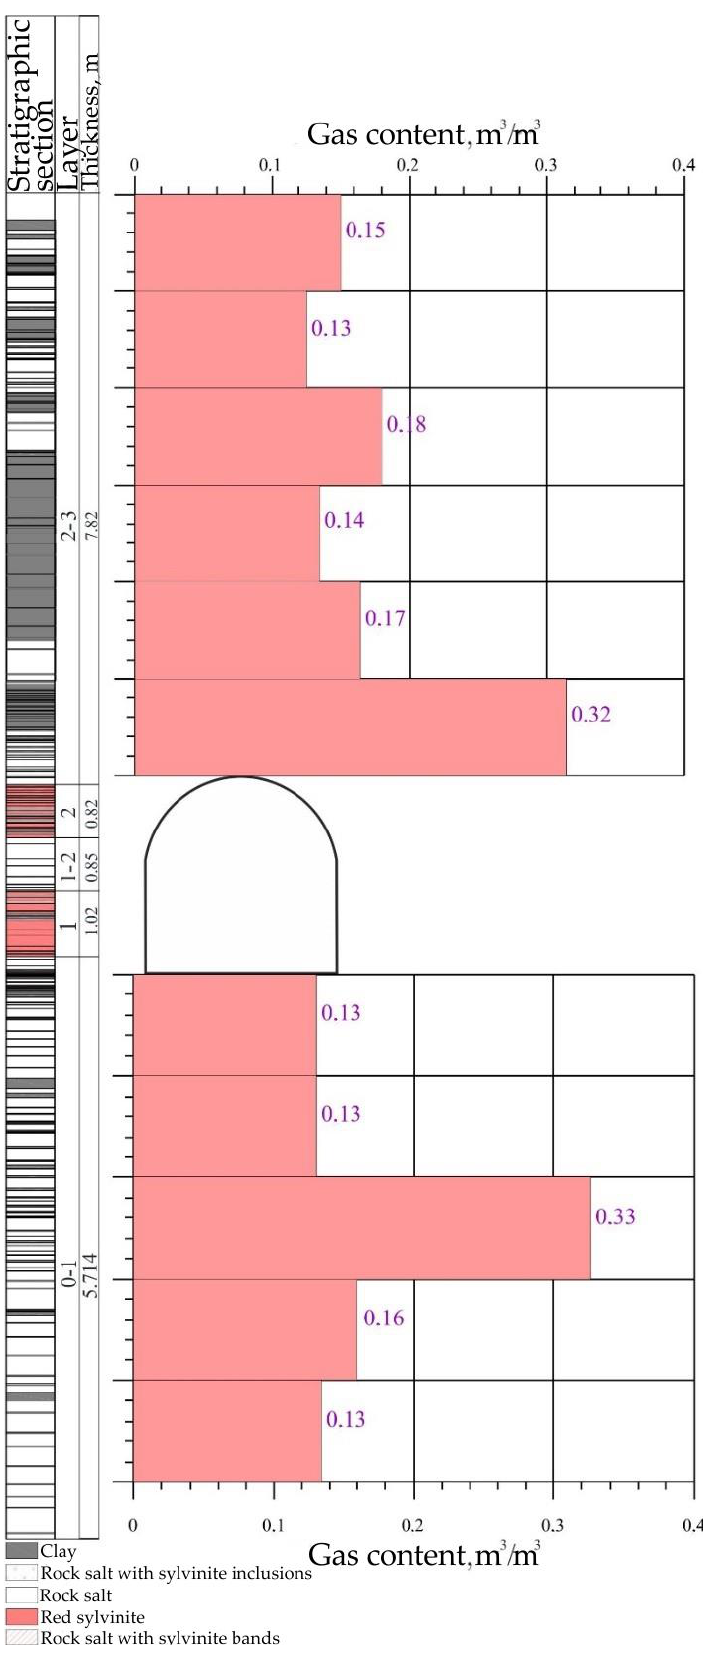
Figure 2. The gas content of the drift roof and soil without the underworking.